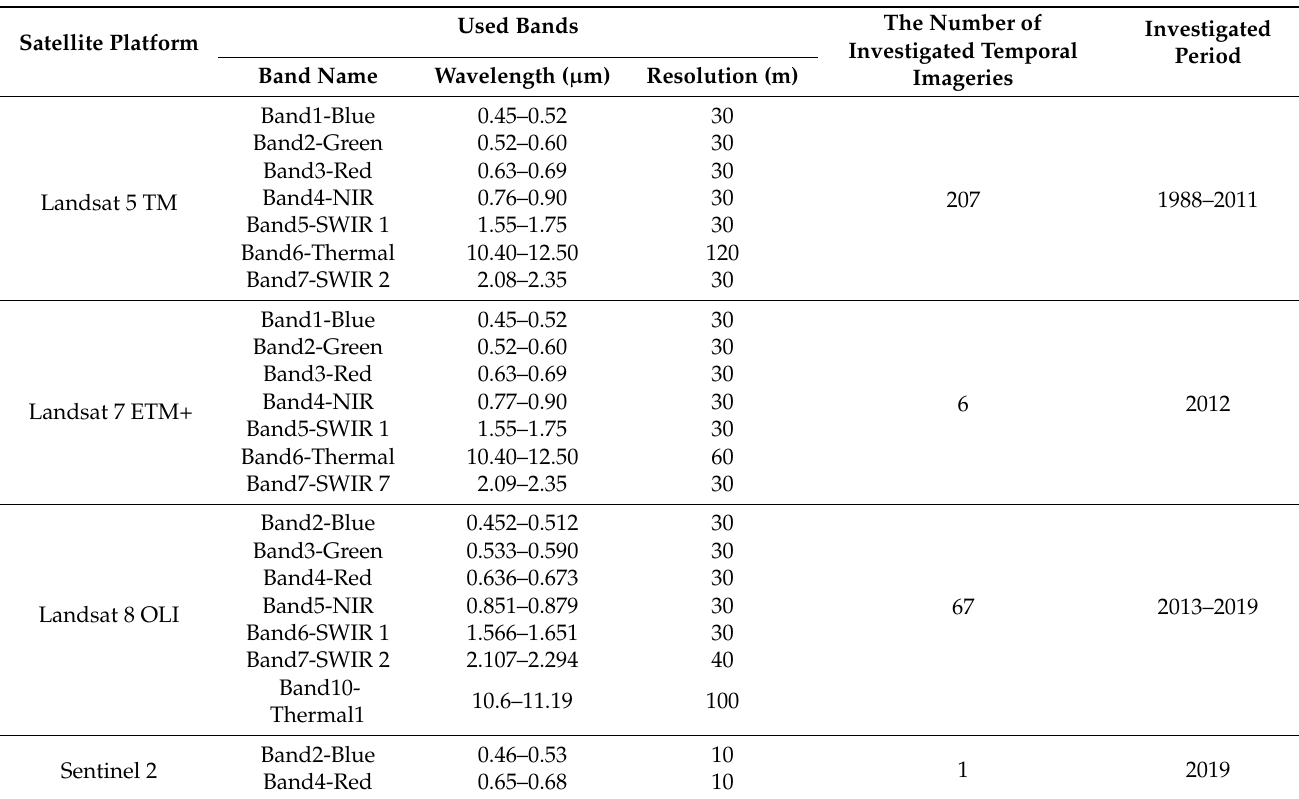
Table 1. Details of the investigated remote sensing